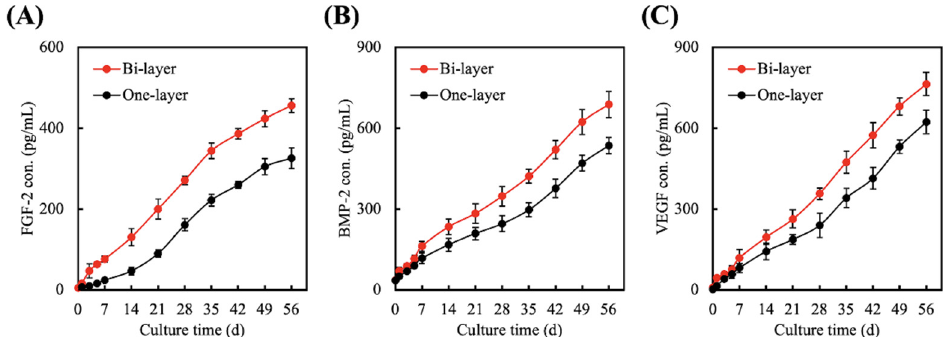
Figure 7. Evaluation of ( A ) FGF-2, ( B ) BMP-2, and ( C ) VEGF secreted from hGF encapsulated in one-layer or bi-layer scaffolds for different time-points.